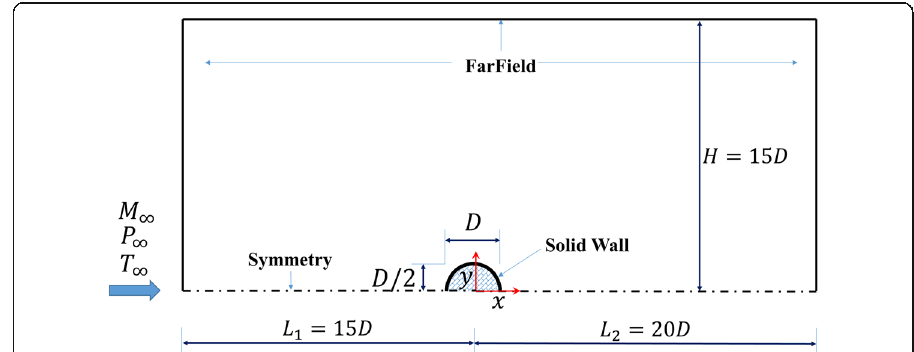
Fig. 1 Sketch of the computational domain for an external flow over a two-dimensional circular